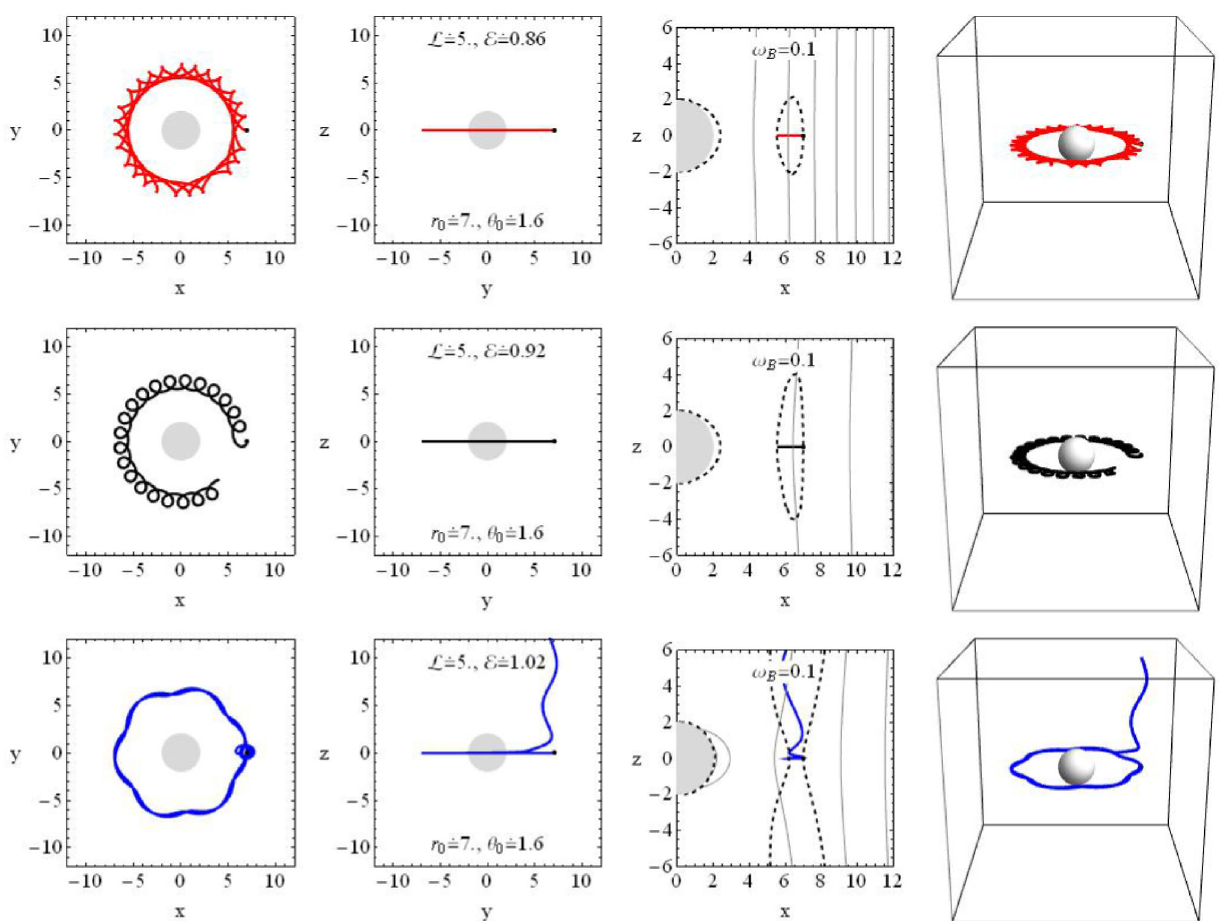
from equatorial plane and the distance r 0 = 7 M . All trajectories have been plotted for the value of specific angular momentum L = 5. Black dashed lines and gray solid lines correspond to magnetic field